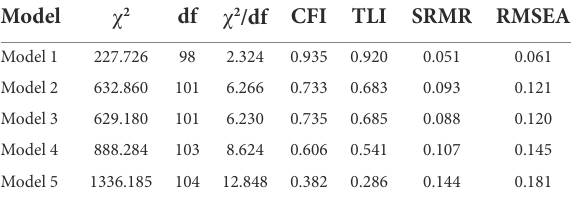
TABLE 2 The results of confirmatory factor analysis